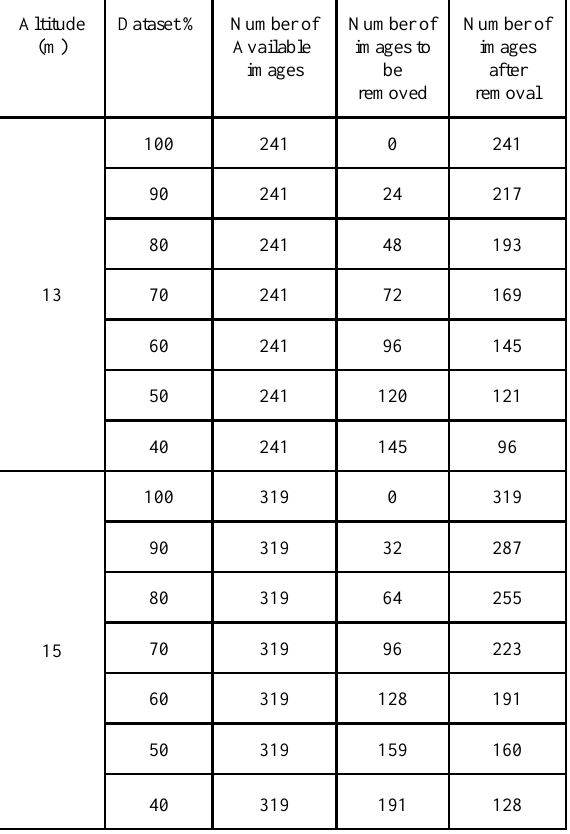
Table 2 . Number of images that were removed at each